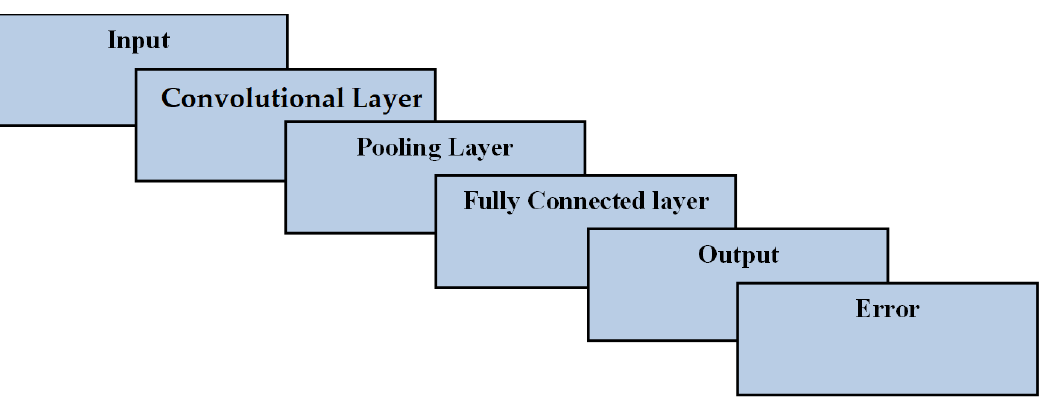
Figure 3. The CNN algorithm ’ s layered workflow for input –